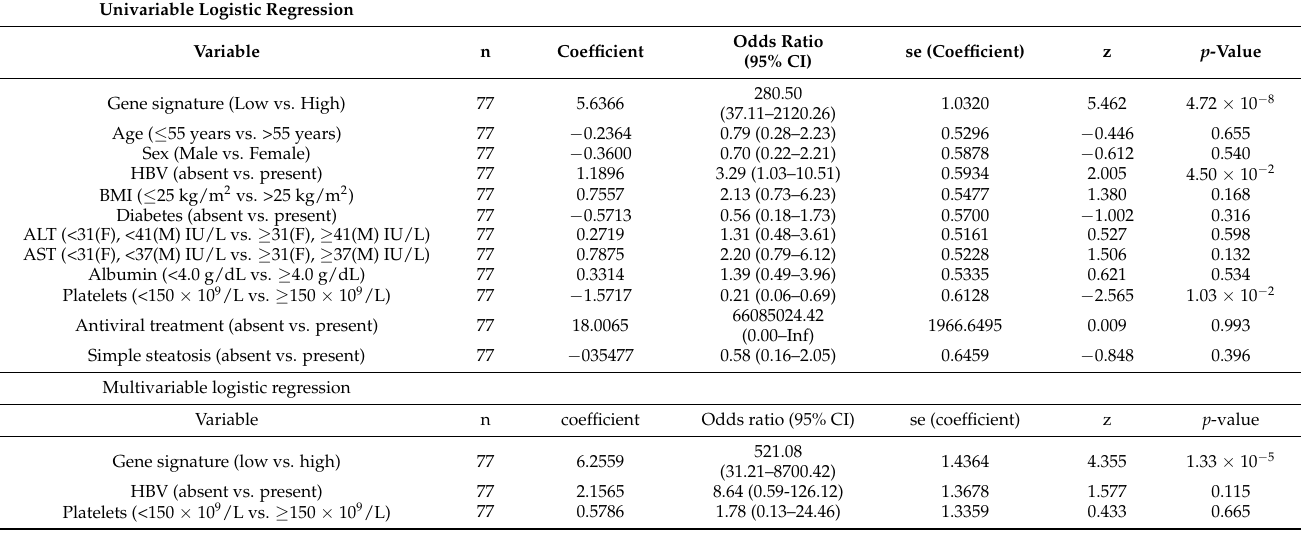
Table 3. Uni/Multi-variable logistic regression analysis.